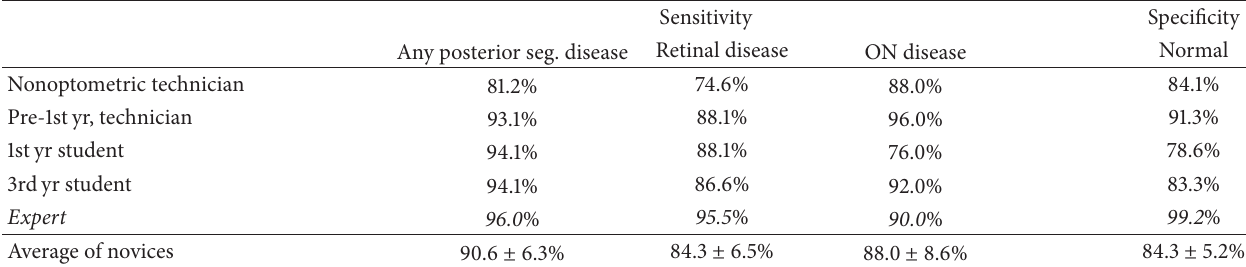
Table 1: Sensitivity and specificity of disease identification using only iWellnessExam™ data, by educational